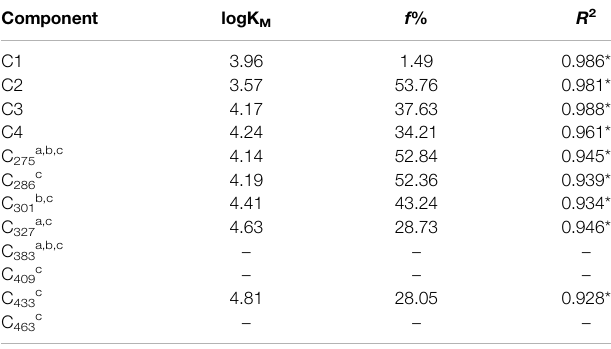
TABLE 1 | Binding parameters are calculated after the modi fi ed Stern – Volmer model.